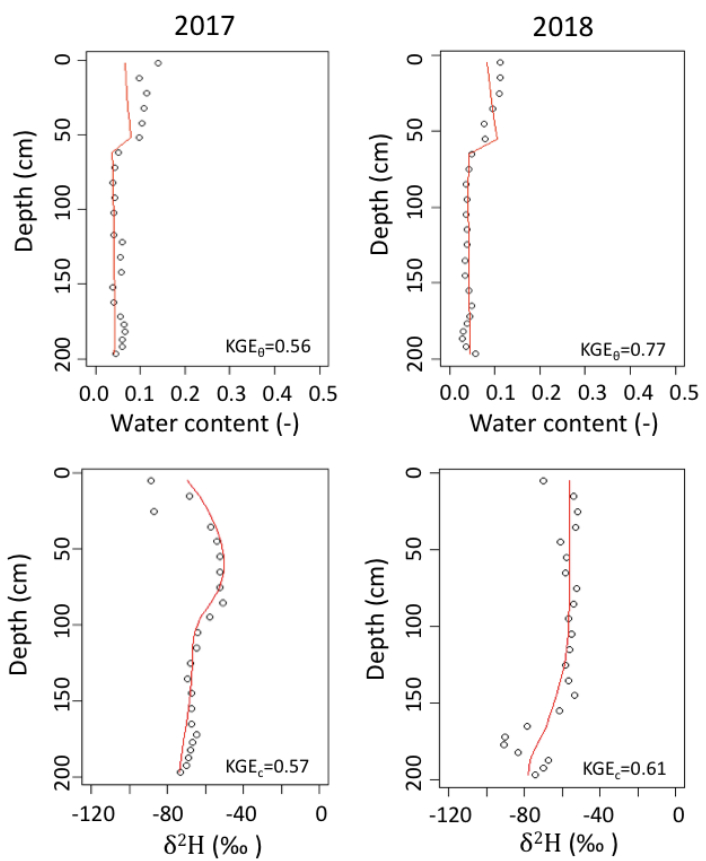
Figure 4. Observed ( circles ) and simulated ( lines ) water content ( top ) and δ 2 H ( bottom ) soil profiles at site SLA, with the best parameter set.